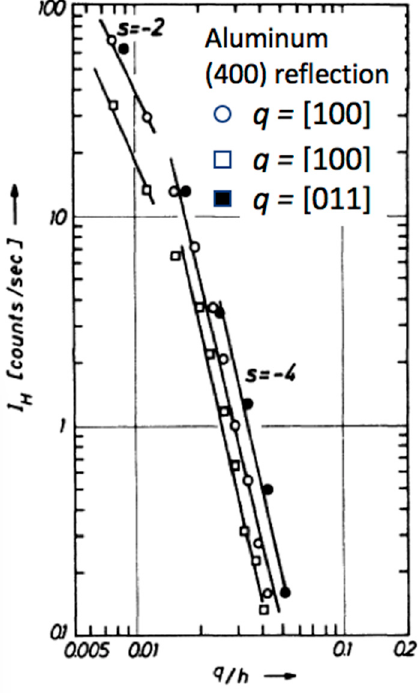
Figure 2. Symmetrical part of the Huang diffuse scattering intensity for helium-temperature electron-irradiated aluminum measured for q in the [100] and [011] directions after annealing to 130 K. Adapted from Figure 9 in Reference [17] with permission.